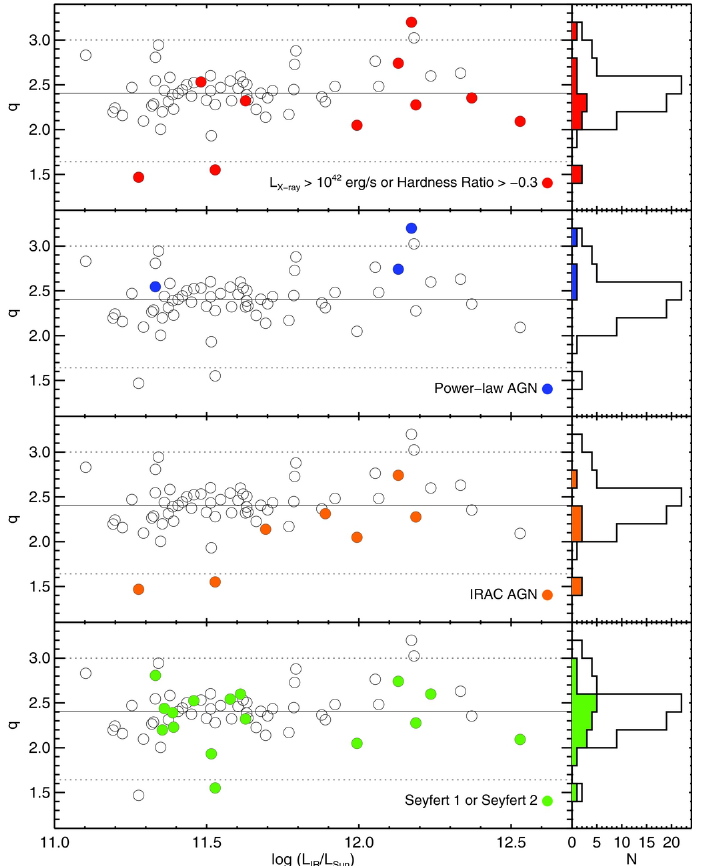
Figure 7. Radio-infrared flux ratio q vs. ν L IR plots are shown for a sample of local (U)LIRGs along with the distribution in q on the right panels. The solid line indicates the median value ( q = 2.41) of the sample, with σ = 0.29. The dotted lines indicate the radio excess ( q < 1.64) and infrared-excess ( q > 3.0) criteria from Yun et al. [145]. From top to bottom are four different AGN indicators (filled circles/histograms): (red) X-ray luminosity and hardness ratio, (blue) mid-infrared power-law slope, (orange) IRAC colors, and (green) optical spectral classification. Figure from U et al. [45]; reproduced with permission from the